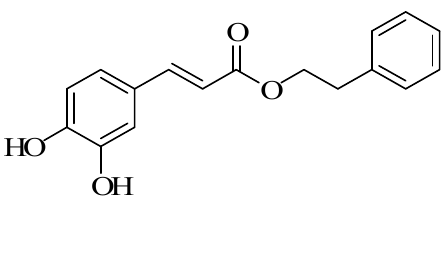
Figure 1. Chemical structure of caffeic acid phenethyl ester (CAPE).